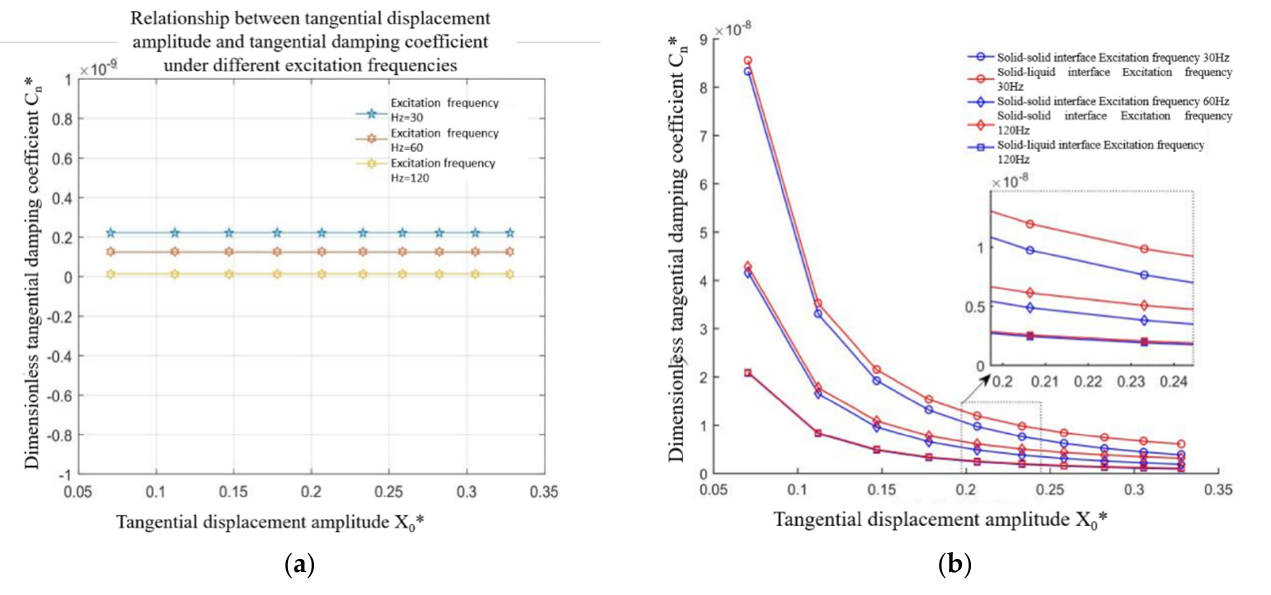
Figure 8. Relationship between the tangential displacement amplitude and the tangential damping coefficient of the solid–solid and solid–liquid interfaces under different excitation frequencies. ( a ) Fluid contact characteristics, ( b ) solid–solid and solid–liquid bonding face ratio.